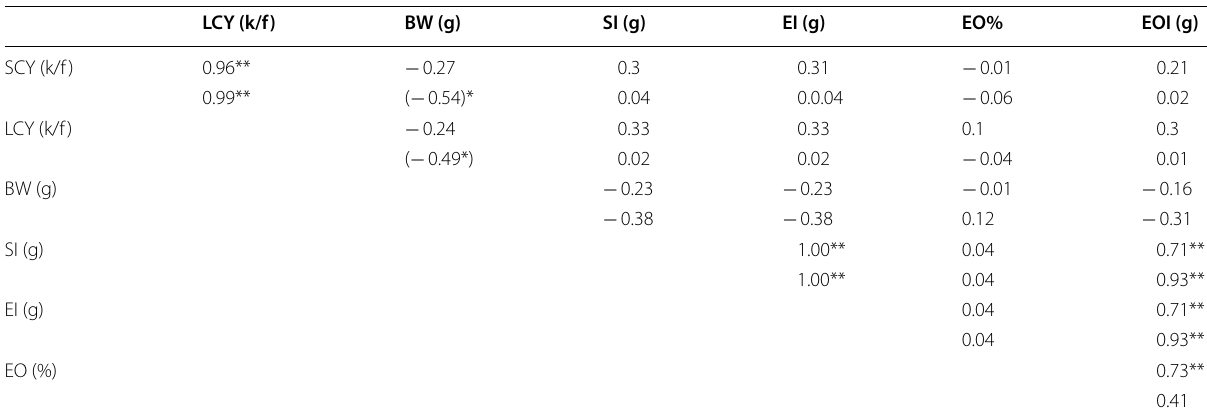
Table 4 Phenotypic (r ) correlation coefficients among all studied traits of cotton genotypes across two seasons p